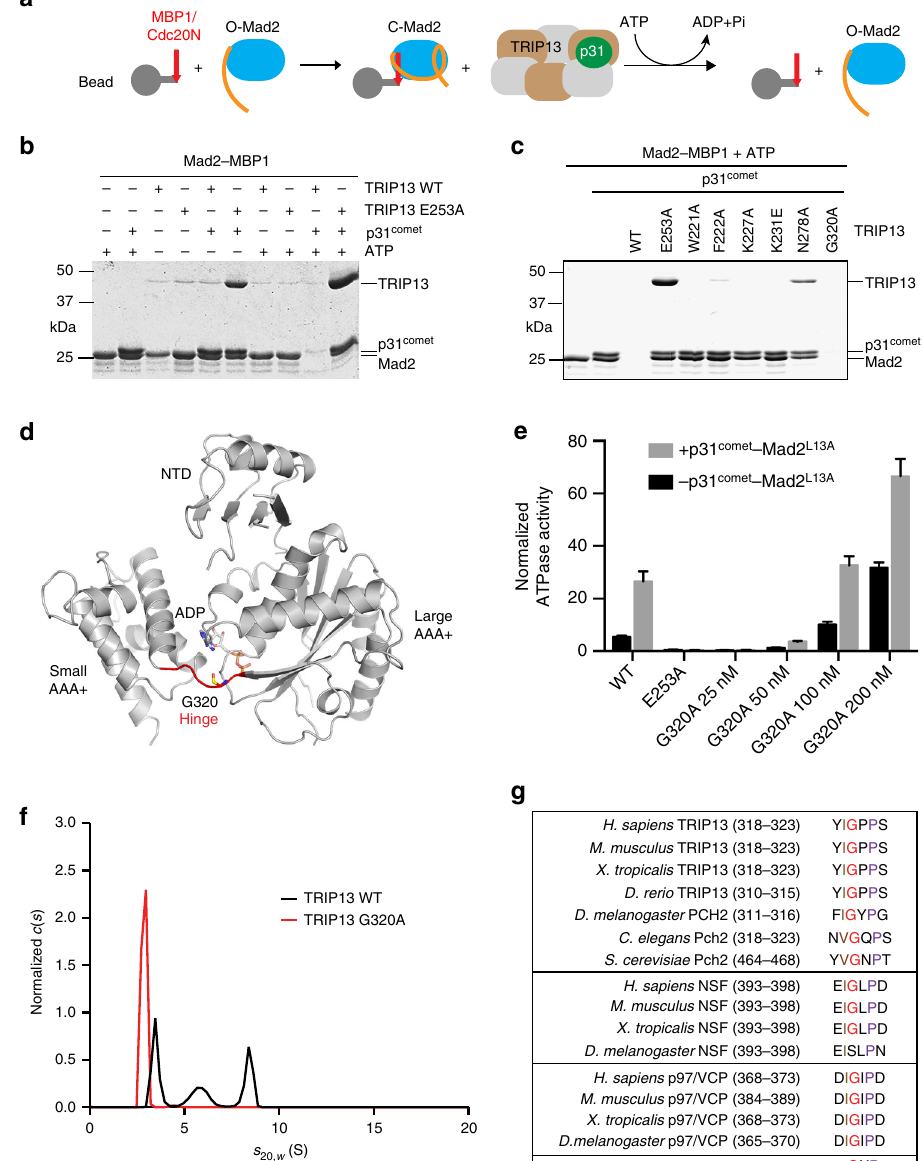
Fig. 5 The TRIP13 hinge is required for conformational dynamics and oligomerization. a Schematic drawing of the Mad2 dissociation assay. b MBP1-coupled beads were fi rst incubated with Mad2 and then incubated with or without TRIP13 wild type (WT) or E253A (1 µ M), Δ N35-p31 comet (2 µ M), or ATP (1 mM). Proteins bound to beads were analyzed by SDS-PAGE and stained with Coomassie blue. c MBP1-coupled beads were fi rst incubated with Mad2 and then incubated with TRIP13 wild type (WT) and the indicated mutants (500 nM) in the presence of Δ N35-p31 comet (1 µ M) and ATP (1 mM). Proteins bound to beads were analyzed by SDS-PAGE and stained with Coomassie blue. d Ribbon diagram of human TRIP13, with the hinge connecting the large and small AAA+ subdomains colored red. ADP and G320 are shown in sticks. e ATPase activities of TRIP13 WT at 25 nM and G320A at the indicated concentrations with (+) or without ( − ) Δ N35-p31 comet – Mad2 L13A . The concentrations of p31 comet – Mad2 were kept at 2:1 molar ratio of those of TRIP13. Mean ± SD; n = 8. f Sedimentation velocity analysis of TRIP13 WT and G320A in the absence of ATP. g Sequence alignment of the hinge region of TRIP13, the D1 domain NSF, and the D1 domain p97/VCP from different